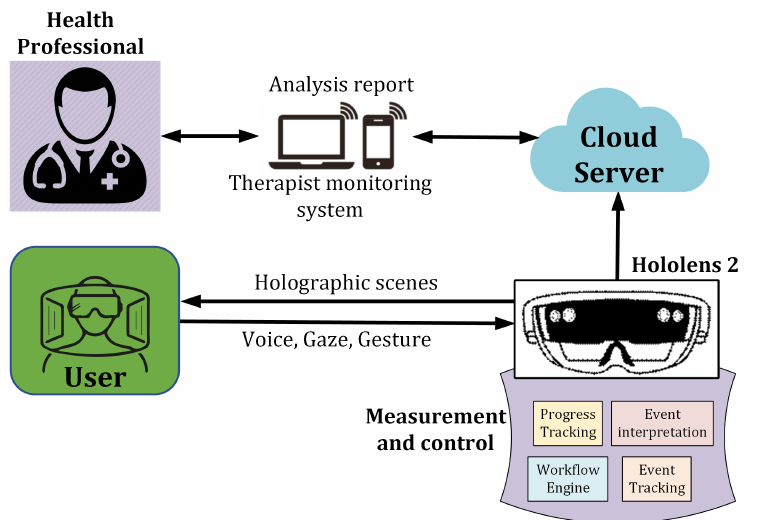
Figure 6. Data flow of the